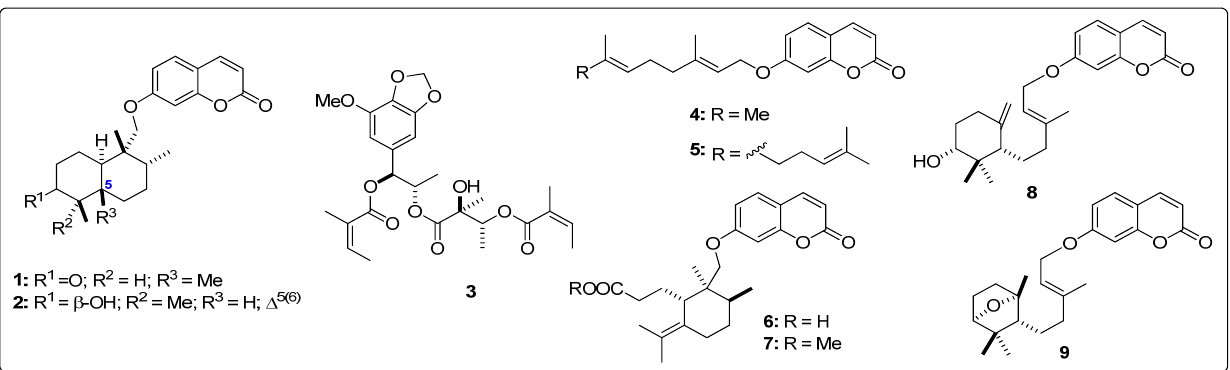
Figure 1. Structures of the tested sesquiterpene coumarins